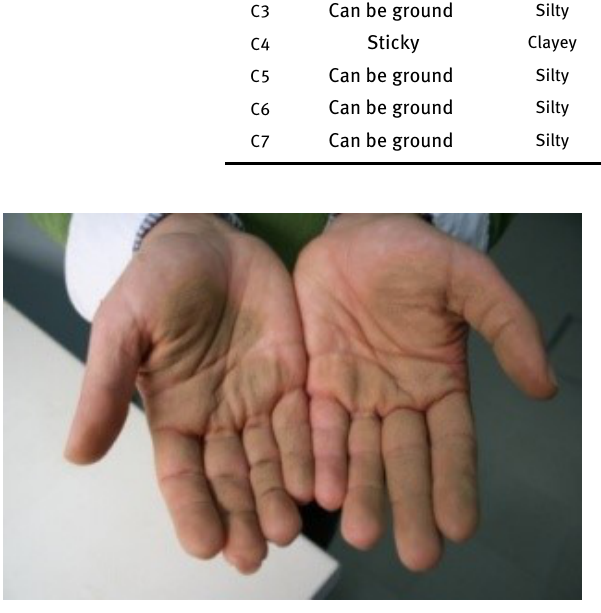
Figure 5: Washing hands test.